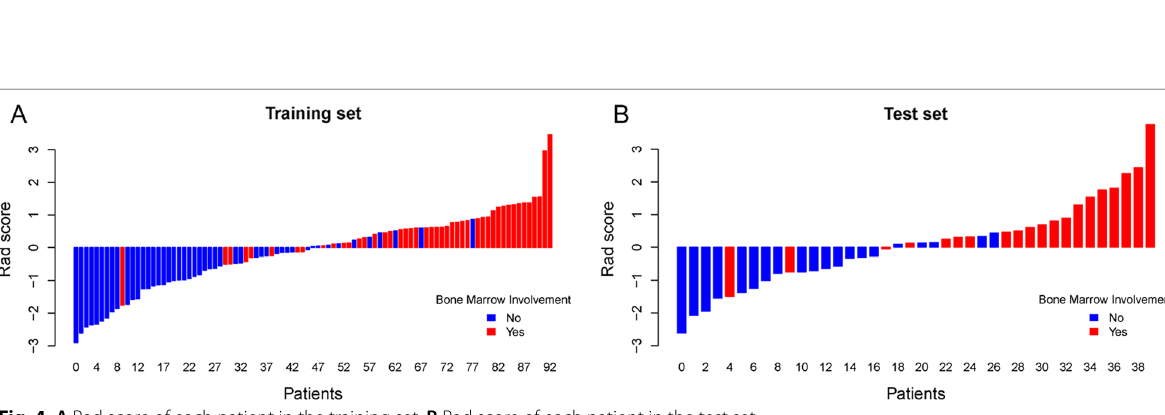
Table 2 Univariate and multivariate logistic regression analysis of clinical characteristics for predicting the BMI in the training set Characteristics Univariate Multivariate OR (95%